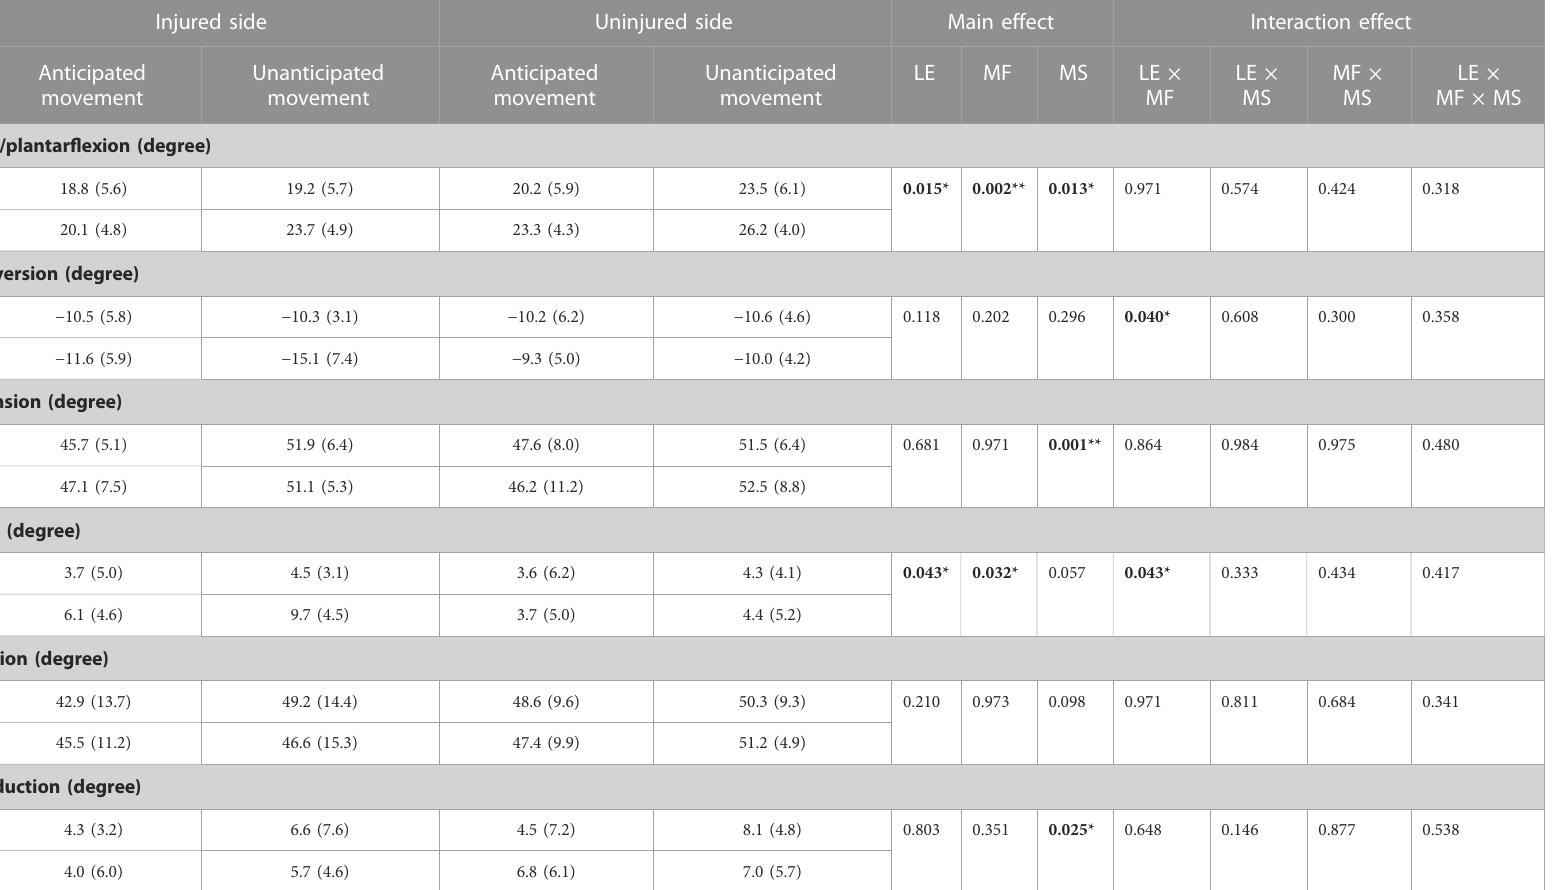
TABLE 1 Maximum Angles of the hip, knee, and ankle joints during side-step cutting. Variables (+/ −